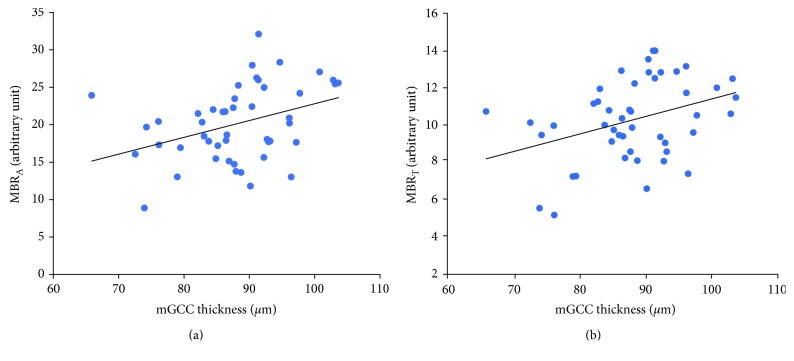
Relationships between mean blur rate in all areas (MBRA), mean blur rate in tissue area (MBRT), and macular ganglion cell complex (mGCC) thickness corresponding to the normal hemifield: (a) MBRA and mGCC thickness, y = 0.341 + 0.225x (r = 0.371, P = 0.010), and (b) MBRT and mGCC thickness, y = 1.987 + 0.094x (r = 0.361, P = 0.013).